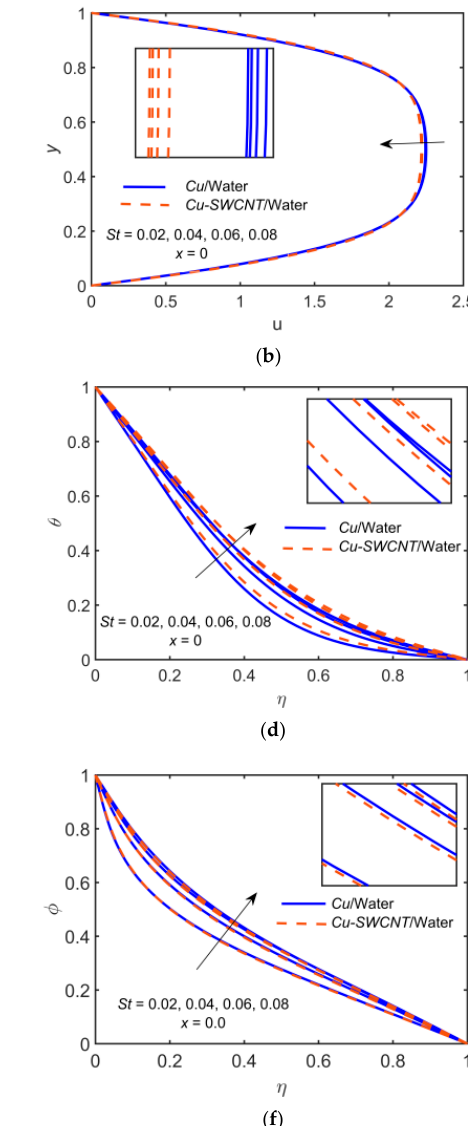
Figure 3. ( a ) The WSS distribution, ( b ) 𝑢 profile at 𝑥 = 0 , ( c ) 𝑢 profile at 𝑥 = 2 , ( d ) θ profile at 𝑥 = 0 , ( e ) θ profile at 𝑥 = 2, and ( f ) φ profile at 𝑥 = 0 for distinct values of 𝑀 .